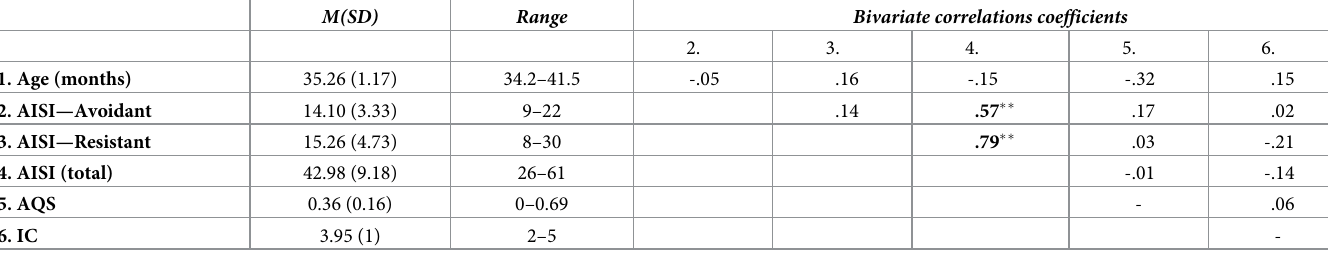
Table 1. Descriptive statistics and Pearson bivariate correlations among the variables in the